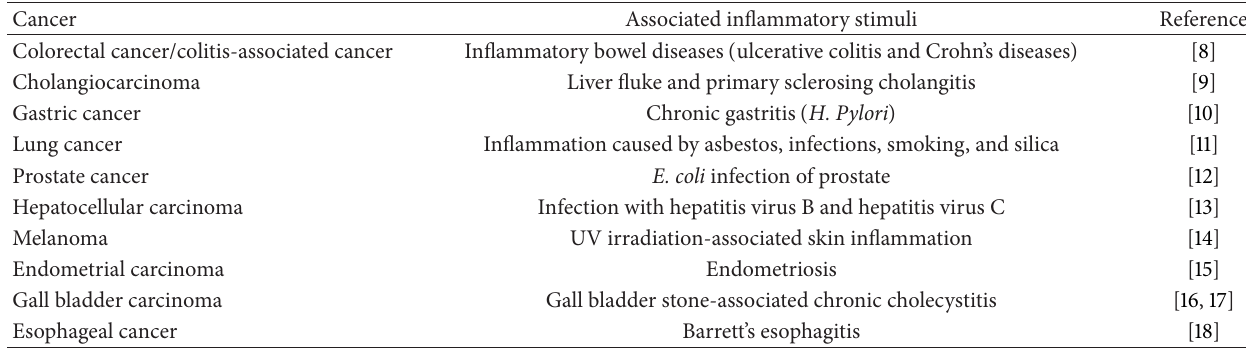
Table 1: Cancer associated with chronic inflammatory